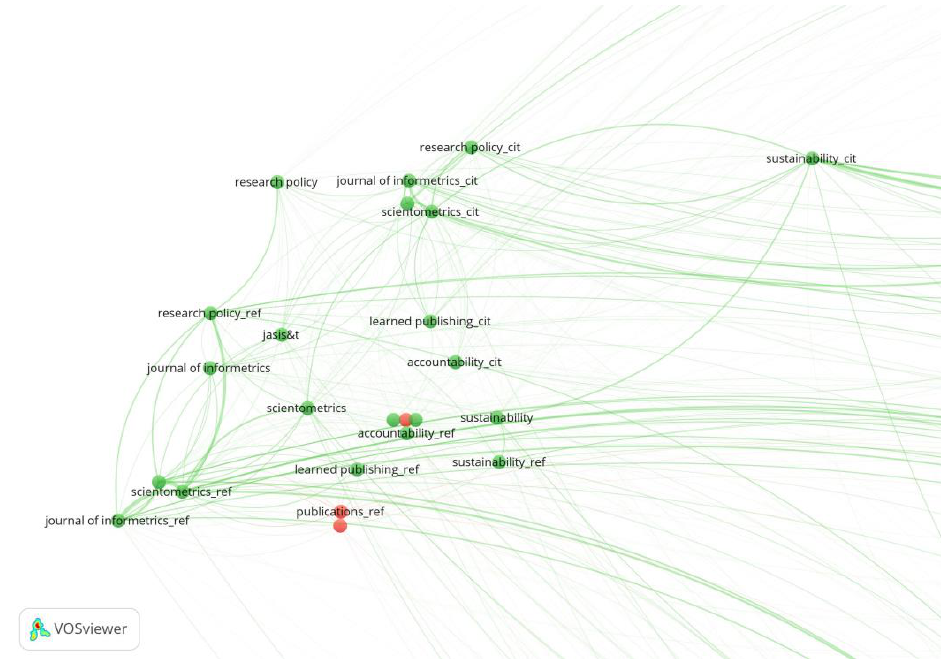
Figure 3. Close up of the total network; the left part shows Publications and its close related journals. Node size corresponds to the number of publications. Source: VOSViewer.